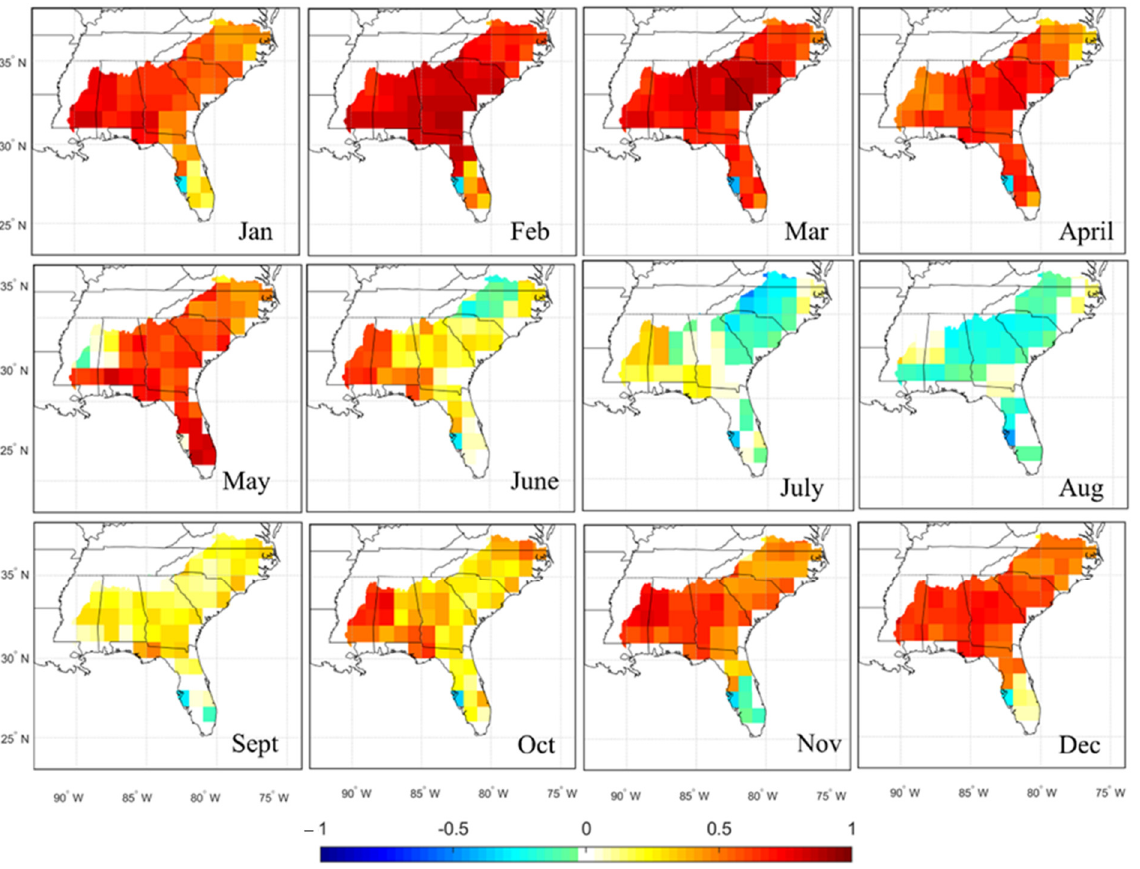
Figure 5. Spatiotemporal correlation maps between GWSA and ENSO.